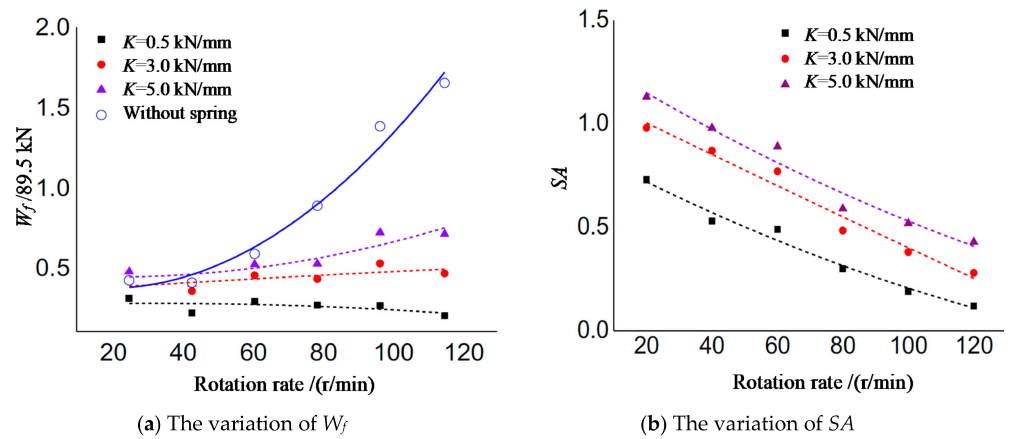
Figure 9. The variation of W f and SA with rotation rate.